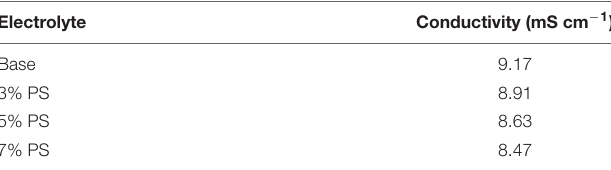
Frontiers in Materials |